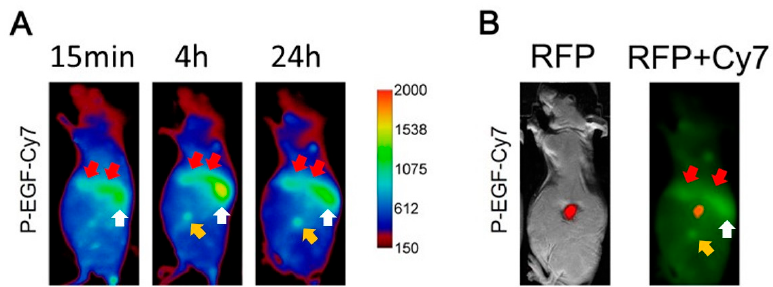
Figure 8. Tumor targeting of polymer probe containing recombinant human EGF ( P-EGF-Cy7 ). White arrow shows kidney, red represents liver and yellow marks the bladder. A ) Cy-7 fluorescence signal in representative mouse at three different times; B ) RFP signal from RFP-expressing tumor cells in red and Cy-7 fluorescence signal in green.